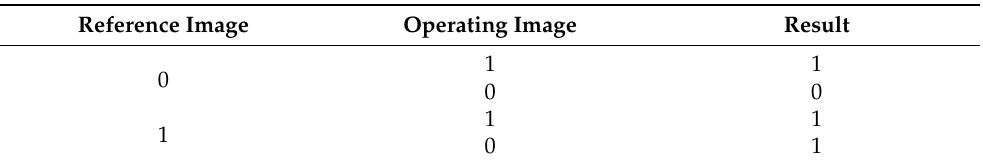
Table 2. The rule for image combination. The first image in fire seasons is used as a reference image, and the remaining images during fire seasons are operating